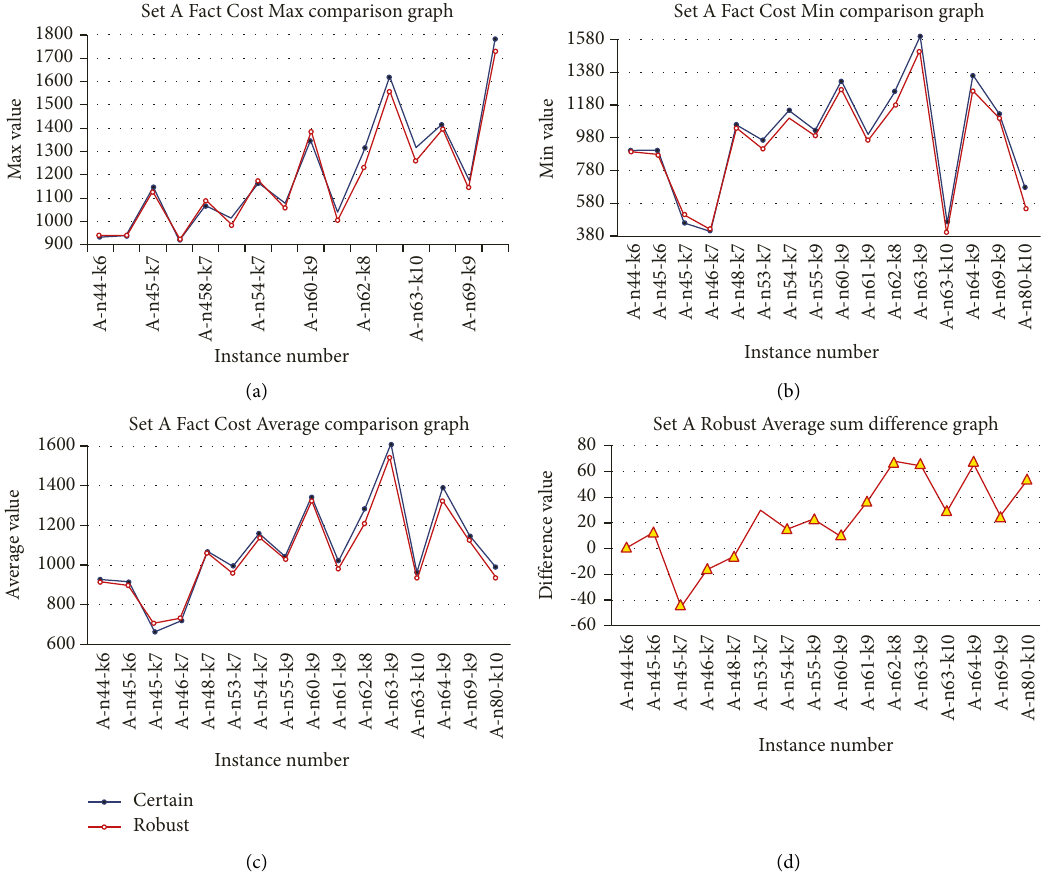
Figure 4: Set A cost comparison graphs. (a) Set A fact cost maximum comparison graph, (b) set A fact cost minimum comparison graph, (c) set A fact cost average comparison graph, and (d) set A robust average sum difference graph.